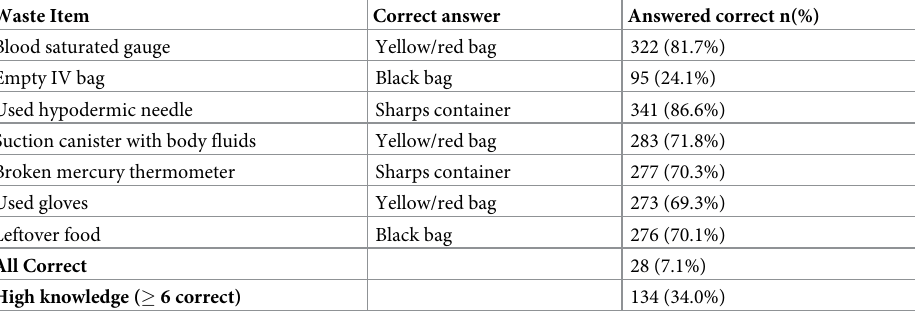
Table 2. Knowledge of correct health care waste disposal practice by individual